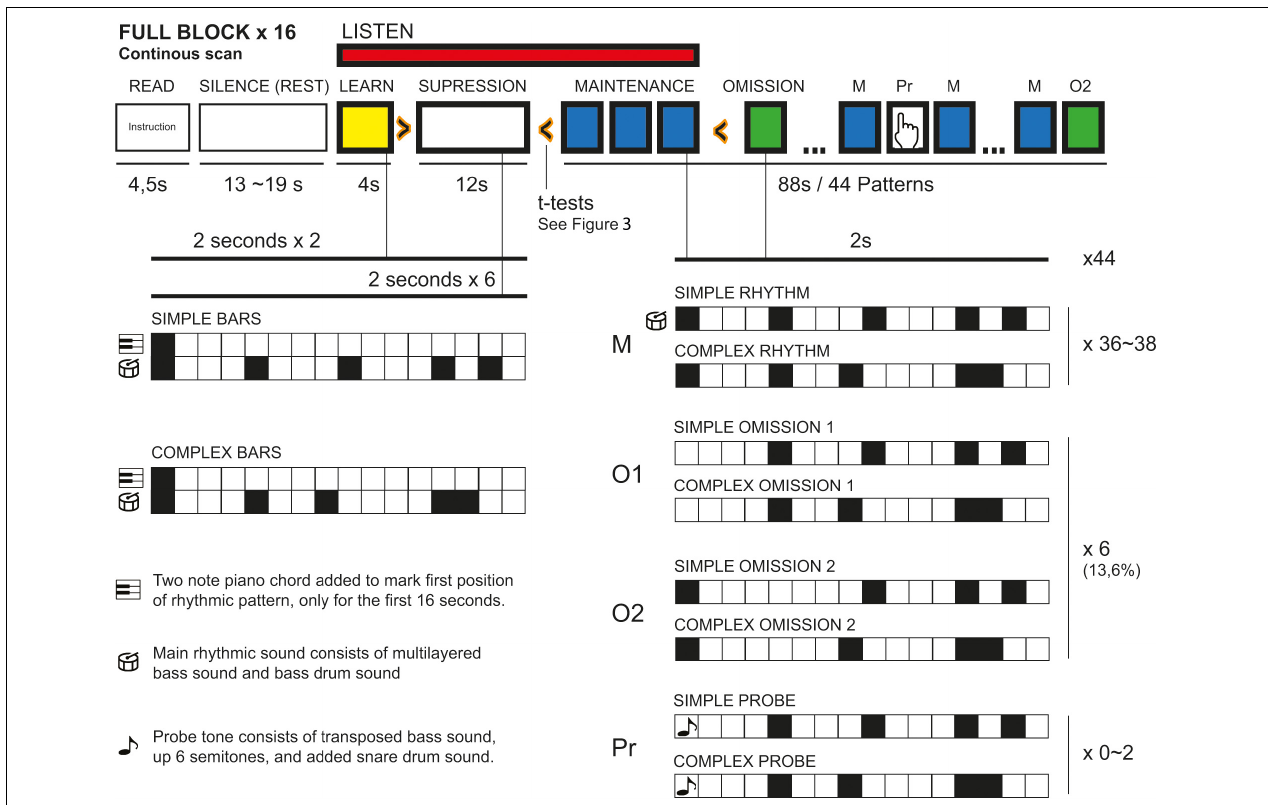
FIGURE 1 | Construct of fMRI